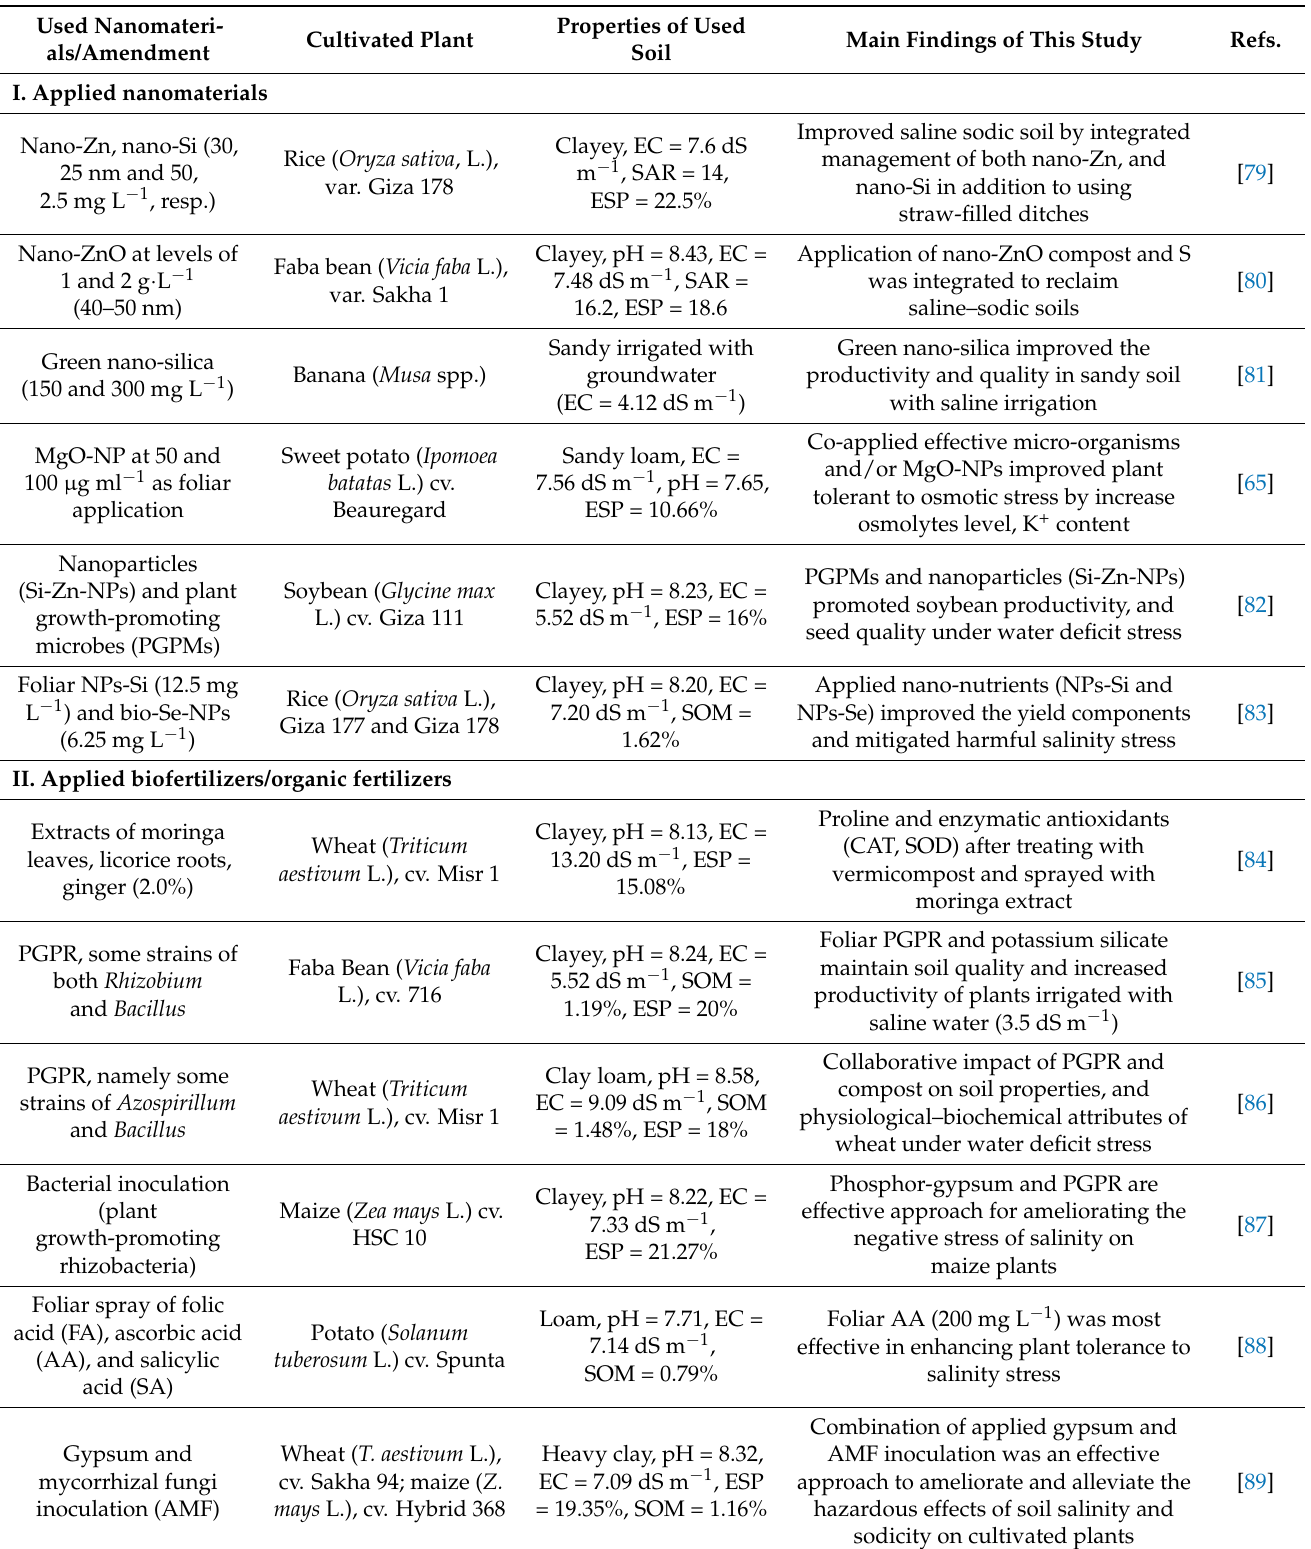
Table 1. Some published studies on managing salt-affected soils using different nanomaterials and